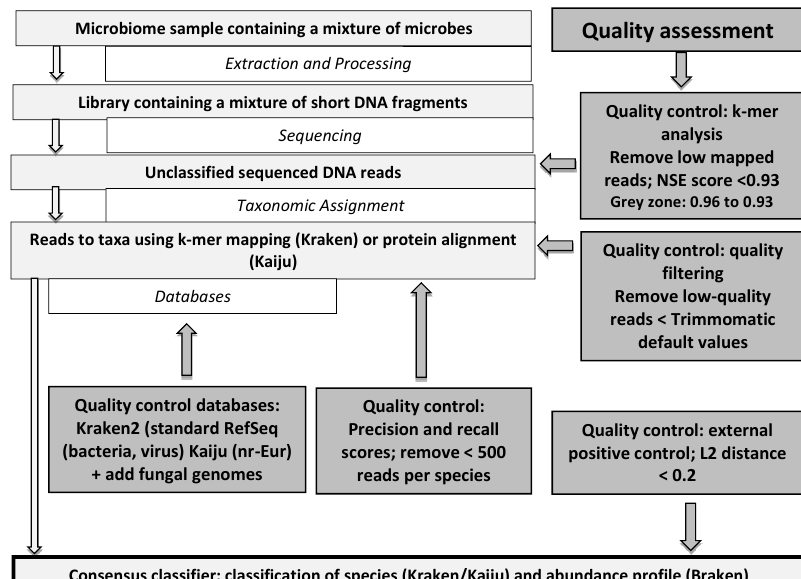
Figure 1. Processing steps and quality assessment for metagenomics data.